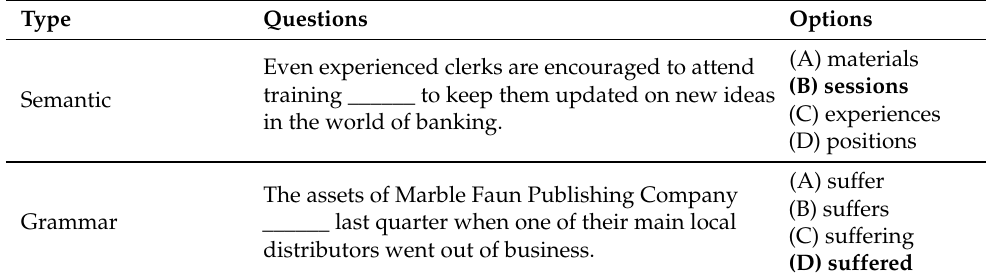
Table 2. Examples of TOEIC Part 5 fill-in-the-blank in a single